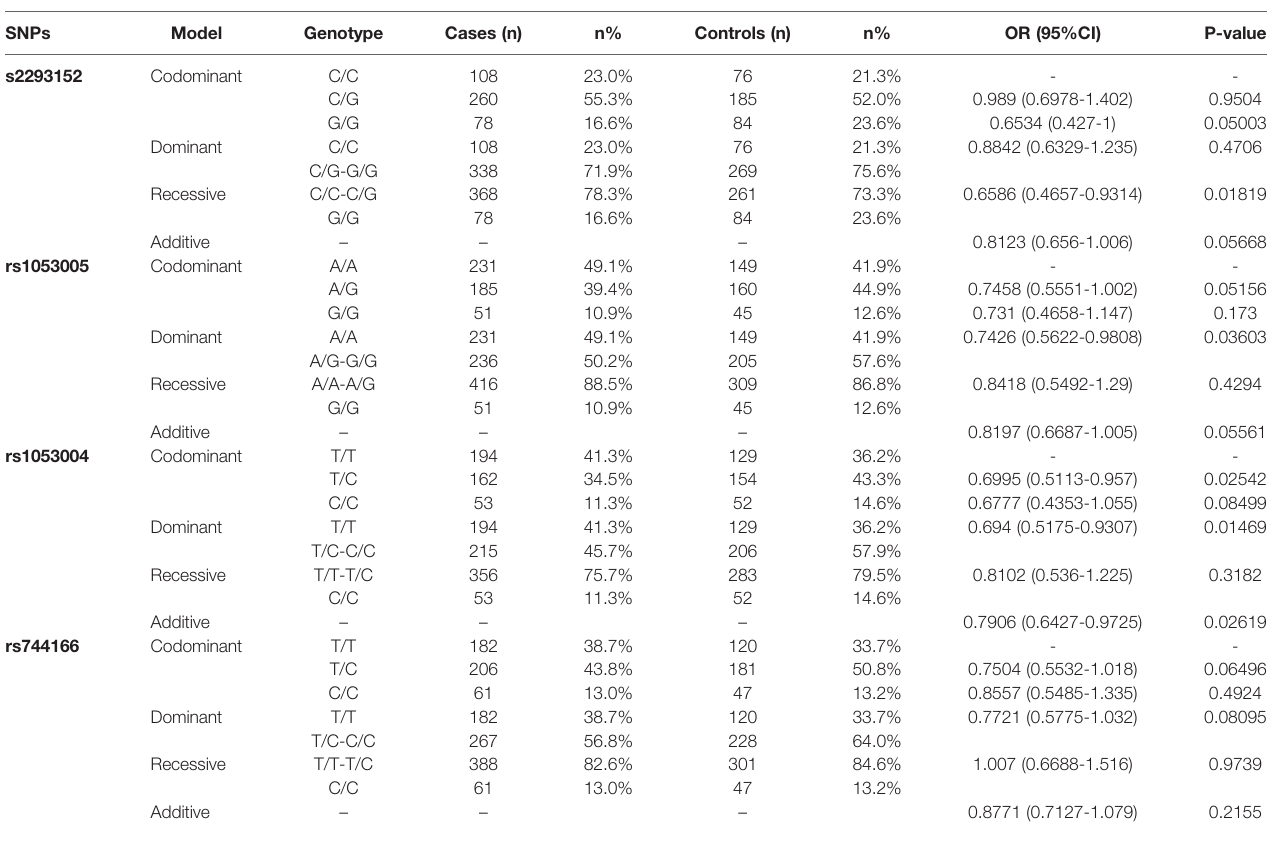
TABLE 3 | Logistic regression analysis